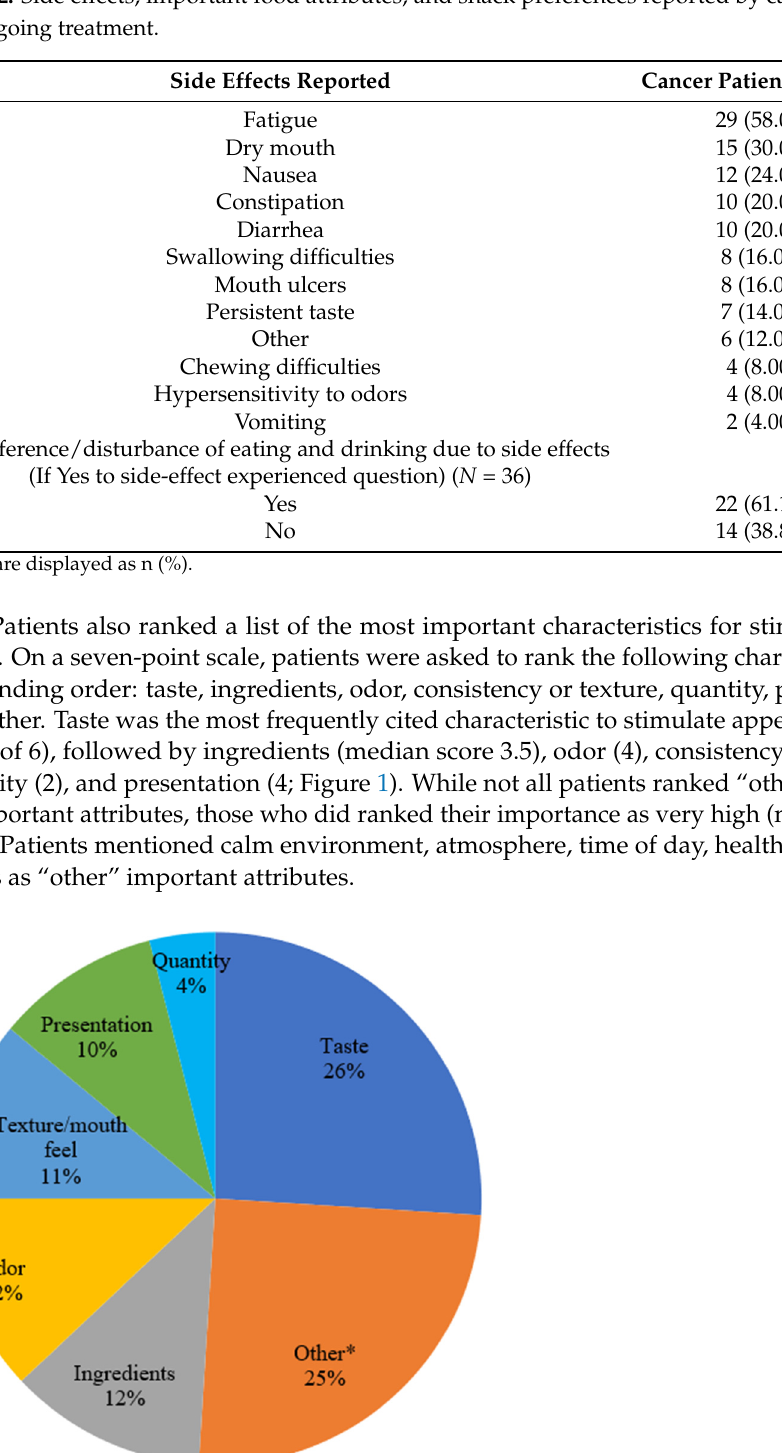
Figure 2. Preferred types of snacks. Distribution of most frequently reported foods or flavors that patients preferred in the preceding month among individuals with cancer. 3.3. Qualitative Findings We identified six themes from the analysis: (1) Spiral of side effects; (2) Pain of eating; (3) Burden of eating; (4) Loss of taste/change in taste; (5) Symptom management; and (6) Solutions. We also identified three through-lines, which served as a second layer of themes that appeared throughout our participants’ experiences. These through-lines